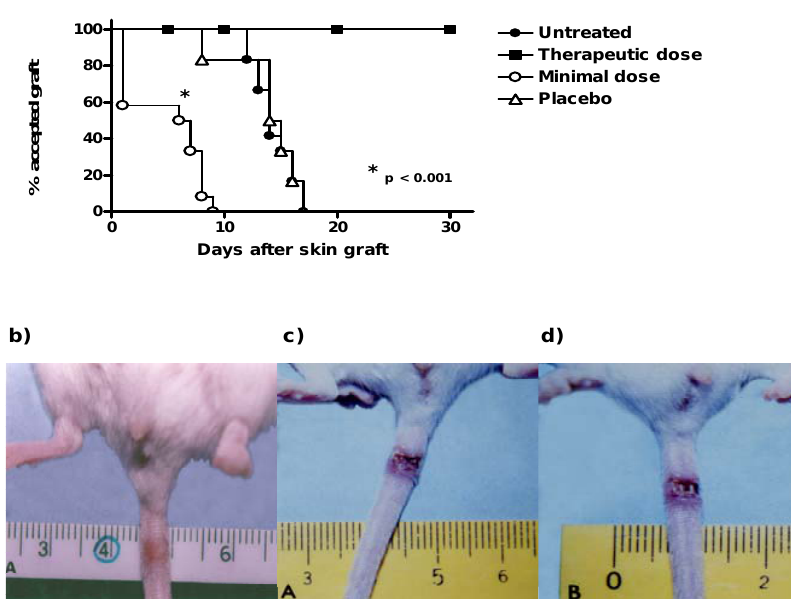
Figure 1. Time course of allograft survival in ICR mice after treatment with consecutive low dose of CsA. ( a ) Survival graft: Animals were grafted in the tail and survival of grafts was monitored for 30 days. The data are representative of two independent experiments (n = 10–12 mice per group). * P < 0.01. ( b–d ) Photographs of tails showing the rejection graft, therapeutic dose of CsA, placebo and consecutive low-dose of CsA,